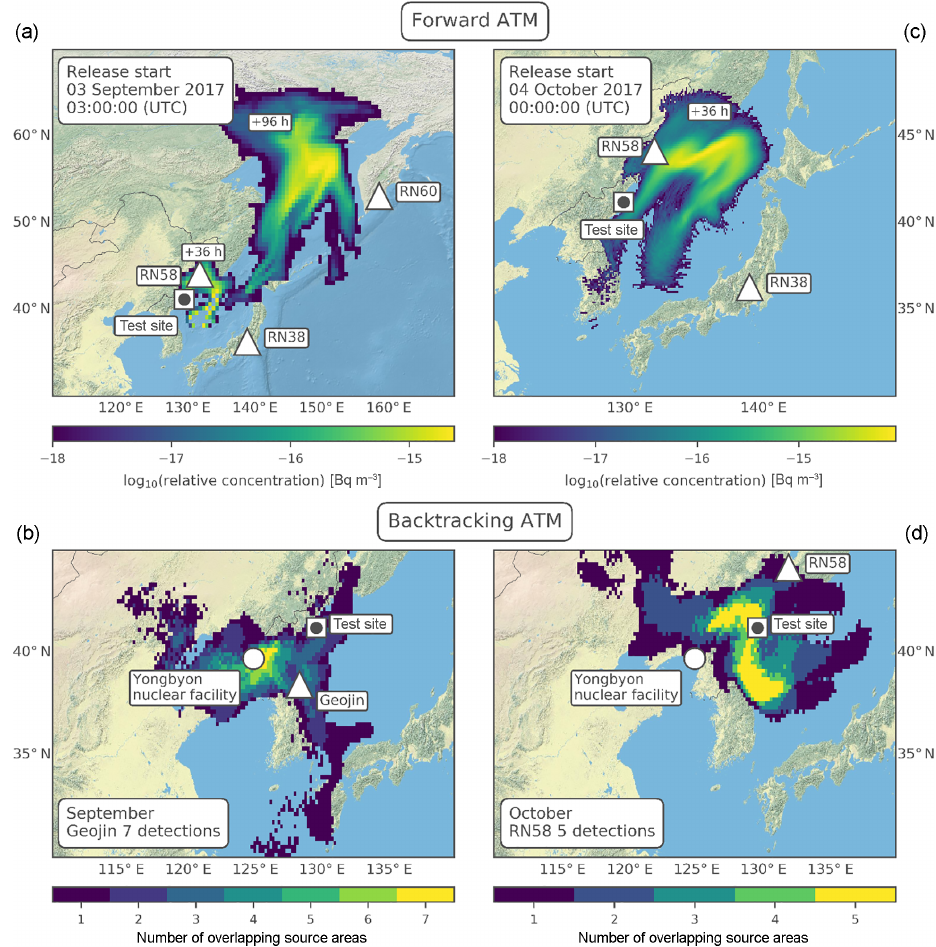
Figure 15. Atmospheric transport modeling results. (a) Forward dispersion modeling after 36 and 96h for an immediate release on 3 September 2017. (b) Number of overlapping backward plumes for seven 133 Xe detecting samples in northeastern South Korea from 7– 10 September 2017 (fixed to 42h transport time for each sample). (c) High-resolution forward dispersion modeling after 36h for a delayed leakage on 4 October 2017. (d) Number of overlapping backward plumes for five 133 Xe detecting samples at RN58 Ussurysk during October 2017 (transport time fixed at maximum sensitivity to North Korean test